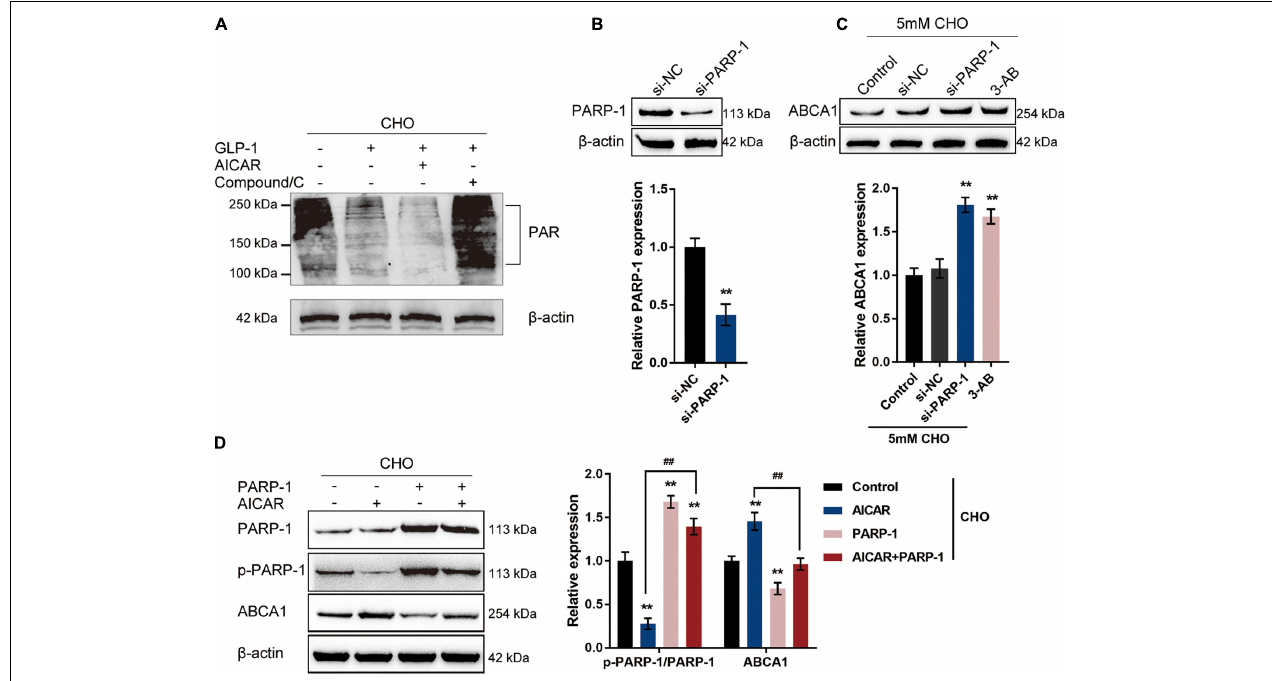
FIGURE 3 | GLP-1 regulates ABCA1 expression through AMPK-dependent inhibition on PARP1 activity. (A) Cholesterol-stimulated INS-1 cells were pre-treated with AMPK activator AICAR or AMPK inhibitor Compound C for 4 h before the addition of GLP-1 and incubated for another 24 h. The protein levels of PAR in INS-1 cell lysates were determined by immunoblotting. (B) PARP-1 knockdown was generated in INS-1 cells by the transfection of si-PARP-1. The transfection efficiency was confirmed by immunoblotting. (C) Cholesterol-stimulated INS-1 cells were transfected with si-PARP-1 or treated with PARP-1 inhibitor 3-AB and examined for the protein levels of ABCA1 by immunoblotting. (D) Cholesterol-stimulated INS-1 cells were treated with AMPK activator AICAR or PARP-1 alone or co-treated with AICAR and PARP-1 and examined for the protein levels of p-PARP-1 and ABCA1 by immunoblotting. ** P < 0.01 compared with si-NC group or control group, ## P < 0.01 compared with AICAR